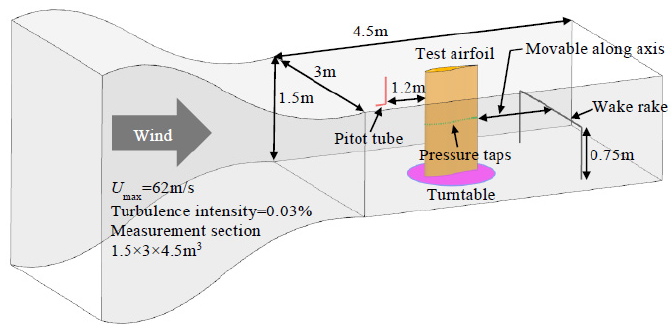
Figure 4. Wind tunnel measurement section size and test airfoil.